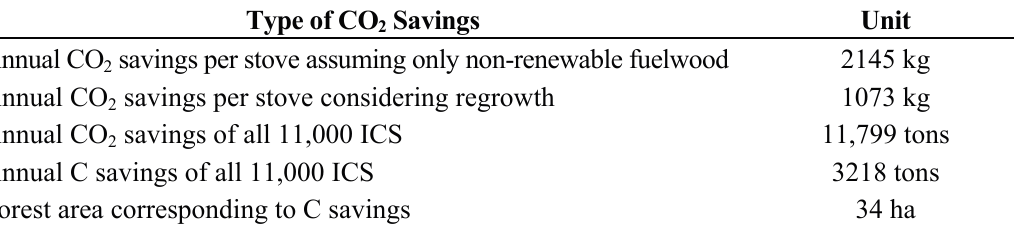
Table 8. Estimated carbon